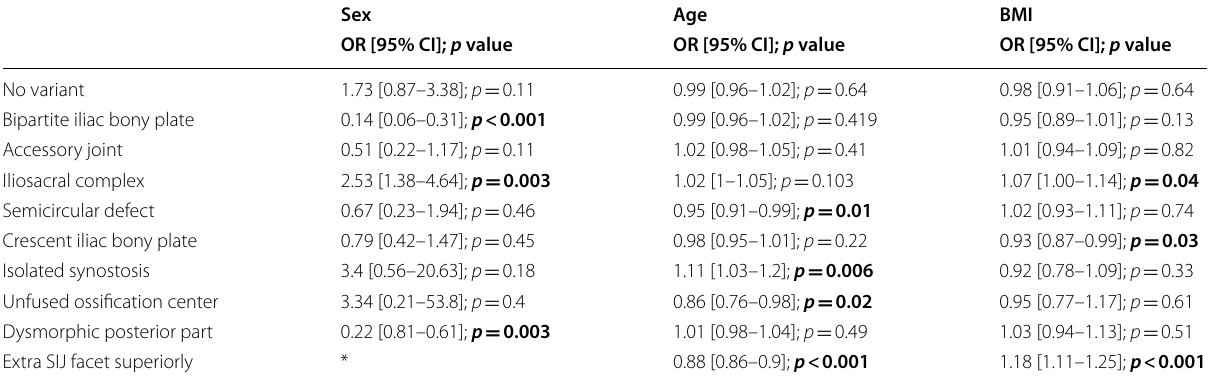
Significant p values are marked in bold SIJ sacroiliac joint; BMI =